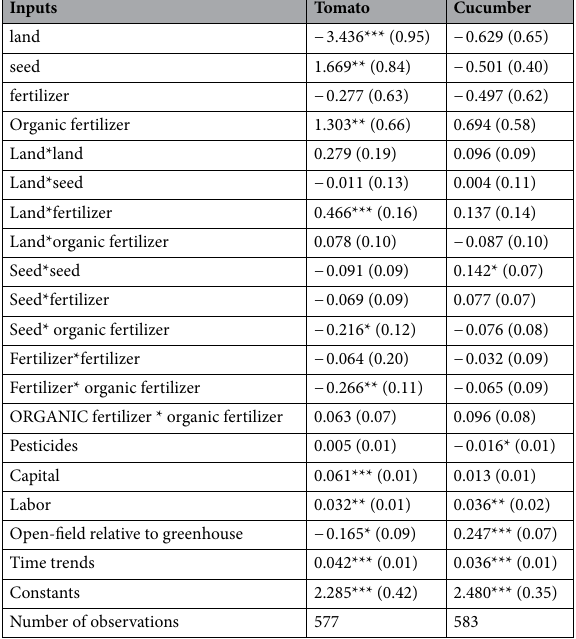
Table 2. Estimation results of the asymmetric translog production function. Growth inputs include land, seed, chemical fertilizer and organic fertilizer. Facilitating inputs include pesticide, capital and labor. Standard errors are shown in parentheses. *,**,*** indicate statistical significance at the 10%, 5% and 1%, respectively.